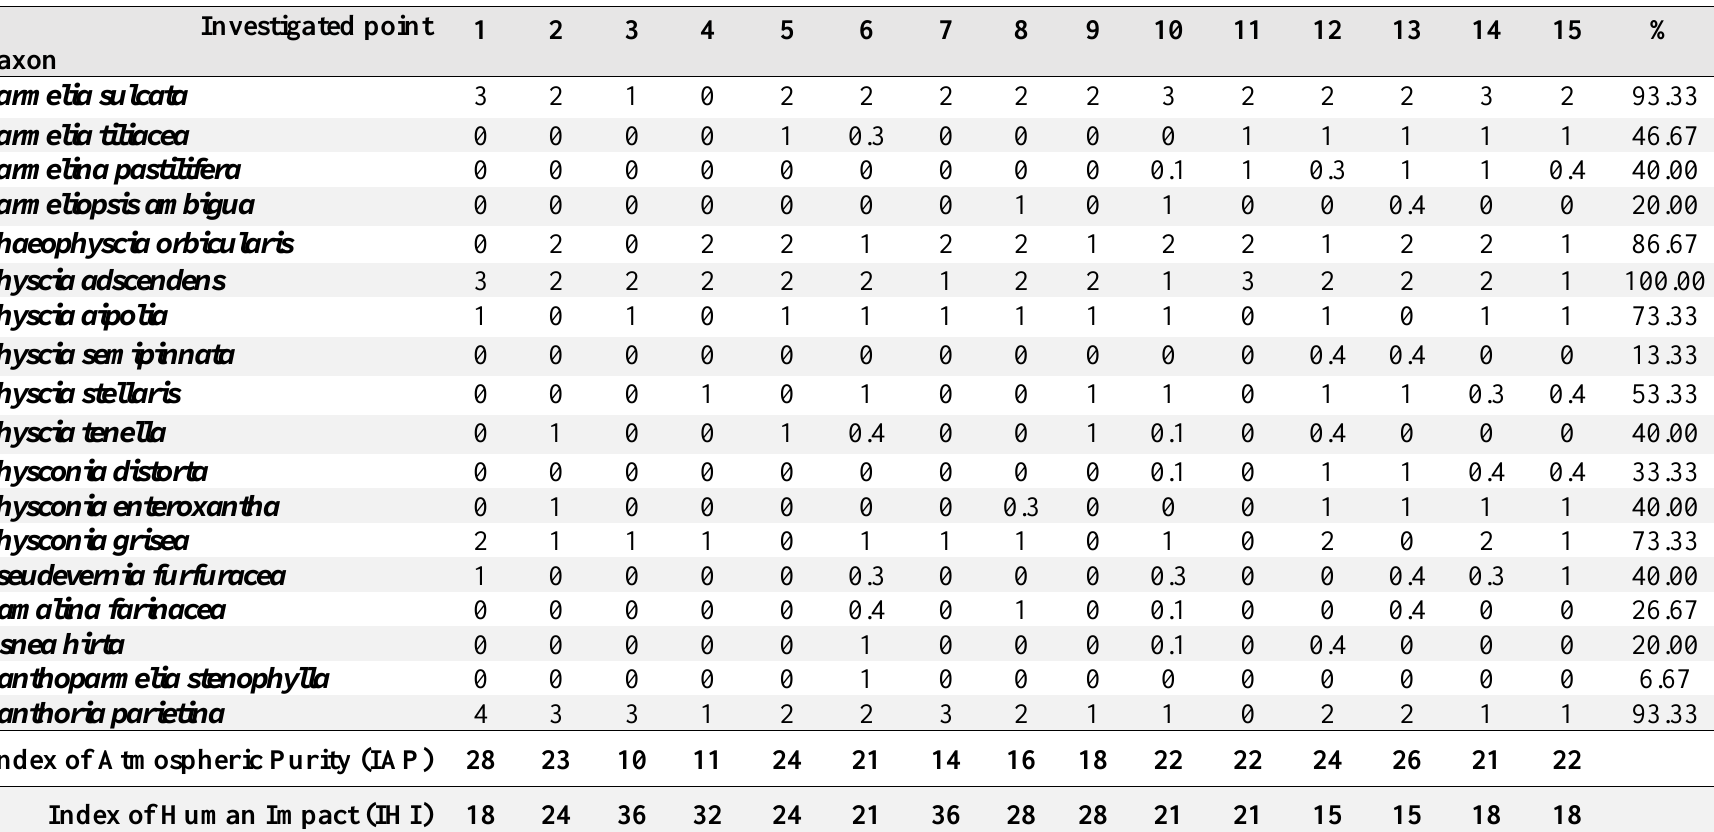
Continuation of Table 2. Lichen species found on the researched area, the values of the coefficient f , the frequency (%) of each taxon and values of IAP and IHI on each of investigated points in